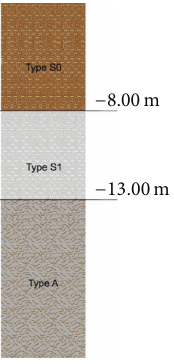
Figure 1: Vertical strata with superficial sand layers (type S0 and type S1) and silt and clay layer (type A). Table 1: Ground parameters for each